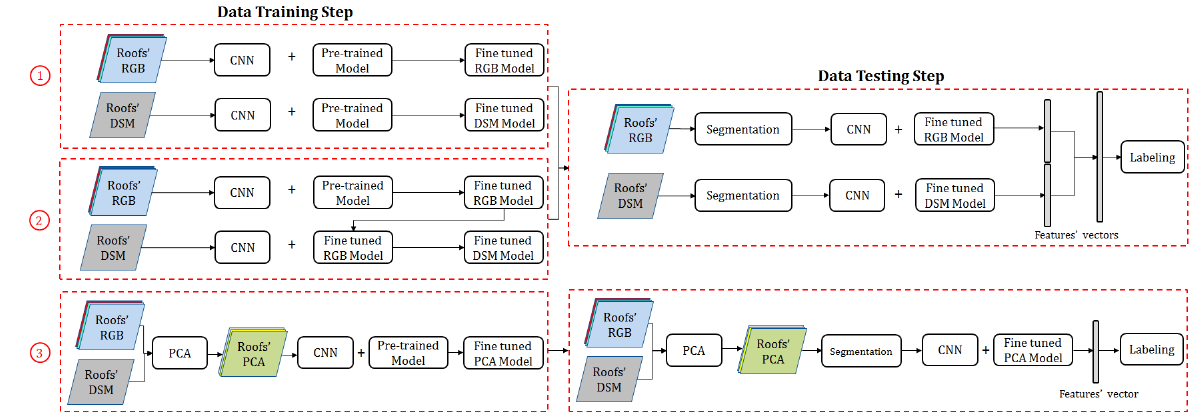
Figure 2. Three strategies for 3D recognition of building roof